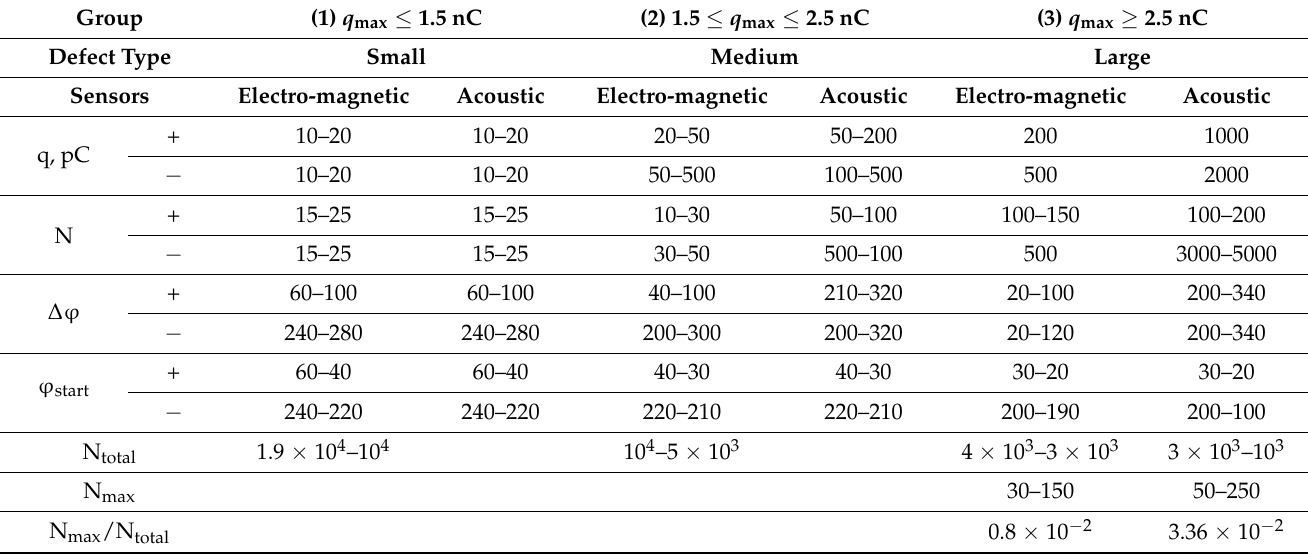
Table 3. PD parameters detected by electromagnetic and acoustic